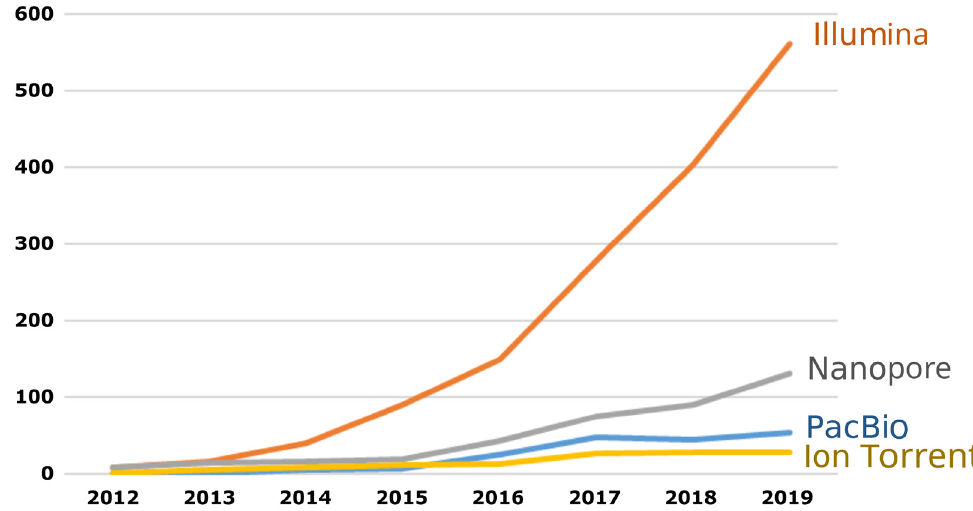
Figure 2. Number of articles published each year in the scientific literature mentioning the selected platform. Source: Scopus, using the search: ALL (“X” AND “antimicrobial